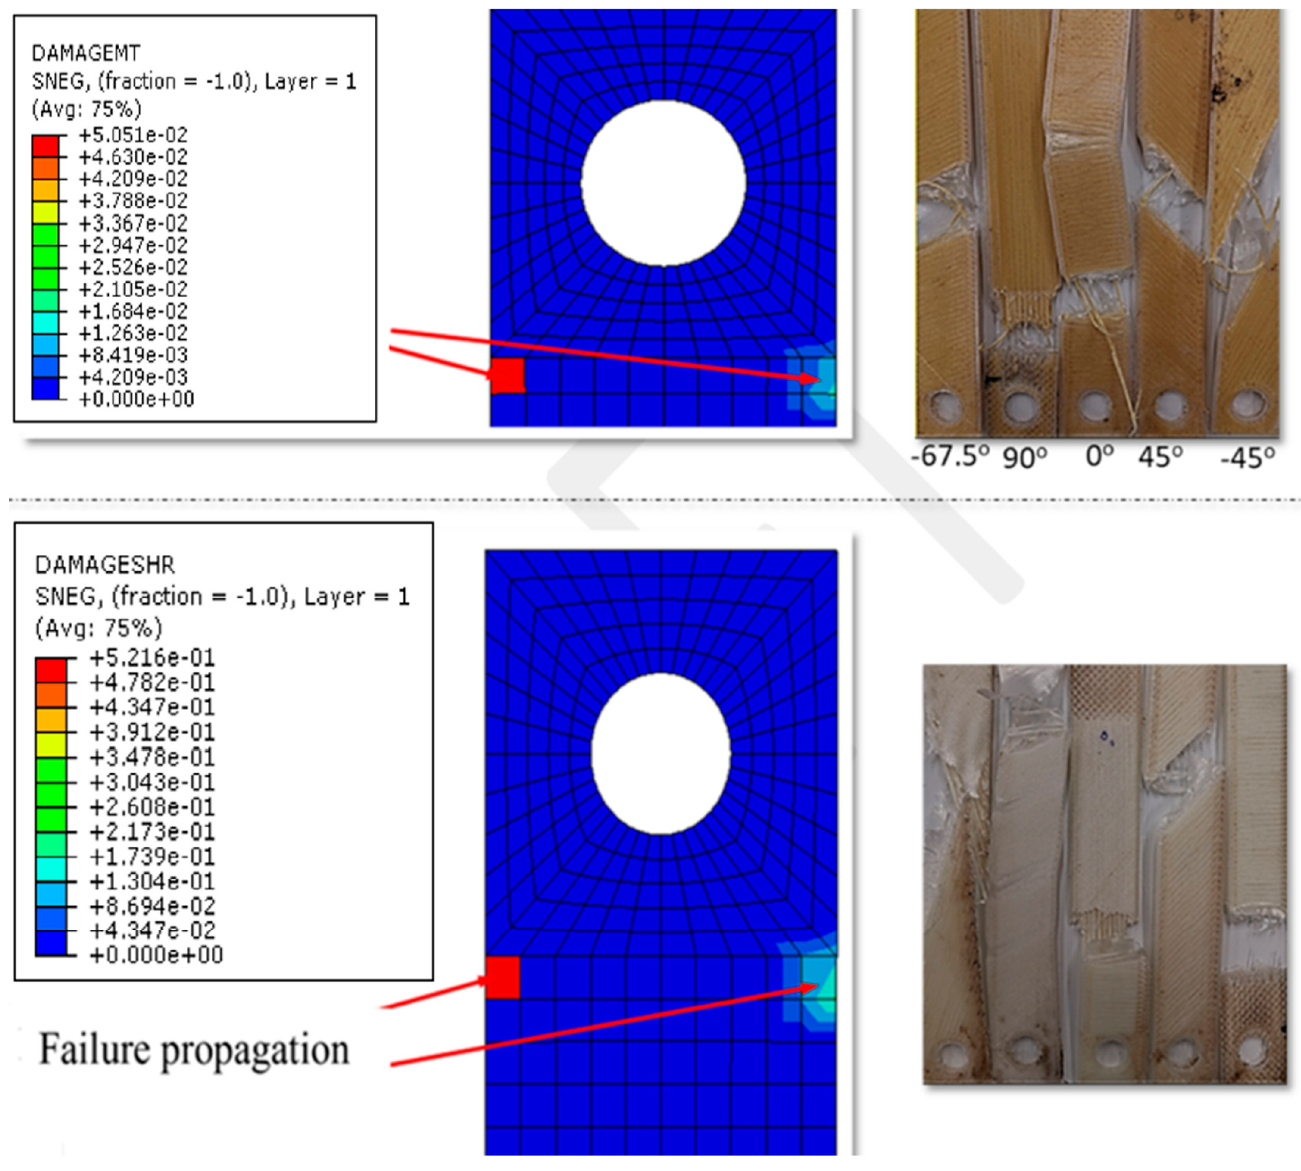
Figure 6. Failure of composite layup predicted by FEA and photographs of a test specimen after the mechanical test (nylon/Kevlar composites ( top ) and nylon/glass fiber composites ( bottom )); the failure samples had dimensions of 150 mm × 25 mm × 2.5 mm (L × W × H).